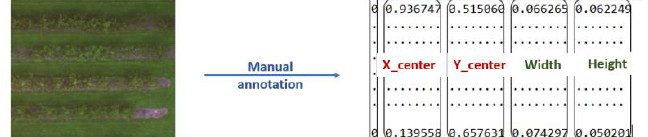
Figure 5 . Splitting the UAV orthomosaic into 512*512 patches.